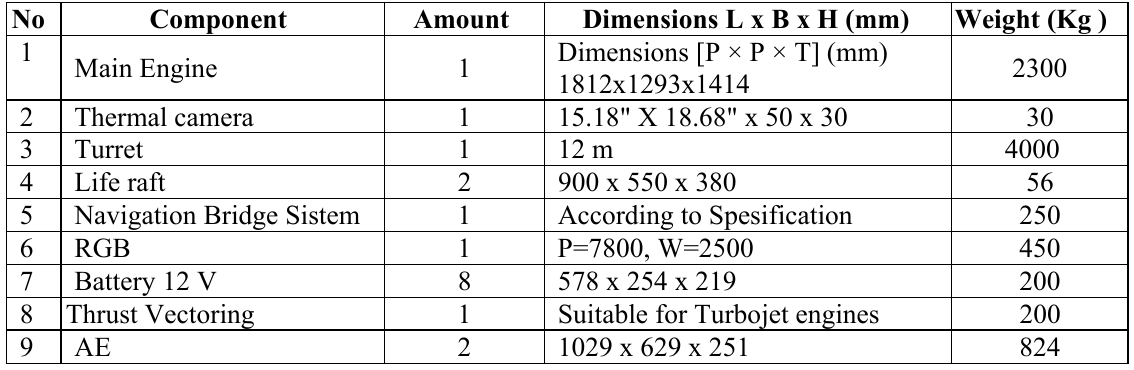
Table 1 Platform Tank Boat